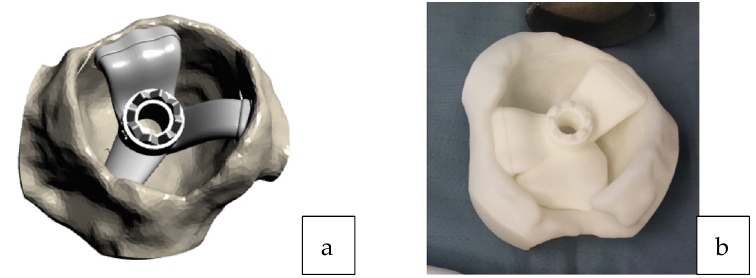
Figure 2. ( a ) Patient-specific femoral guide fitted to the proximal femur. ( b ) Femoral guide fitted to the proximal femur after the osteotomy cut.